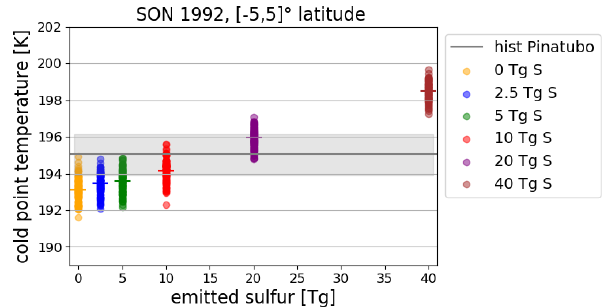
Figure 9. Average cold-point temperature in the inner tropical re- gion [− 5 , 5 ] ◦ latitude as a function of emitted sulfur for all EVAens members in SON 1992. Each point symbolizes one ensemble mem- ber; the horizontal lines denote the ensemble mean. The average cold-point temperature range for the historical Mt. Pinatubo erup- tions (PADS) is shown as a gray line; the shaded region shows the extent between corresponding maximum and minimum cold-point